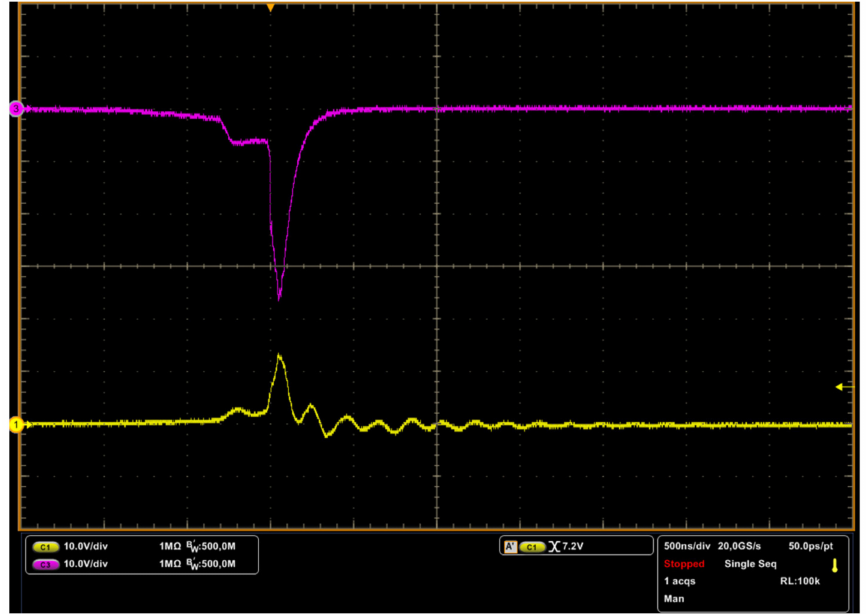
Figure 11. Oscillograms of reverse discharge current from the model antenna (yellow signal), discharge current from the solid stripe electrodes (magenta signal) (shunts 0.5